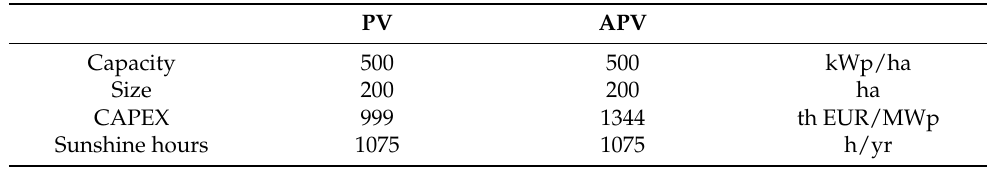
Table 7. Sensitive parameters for PV-GM and APV